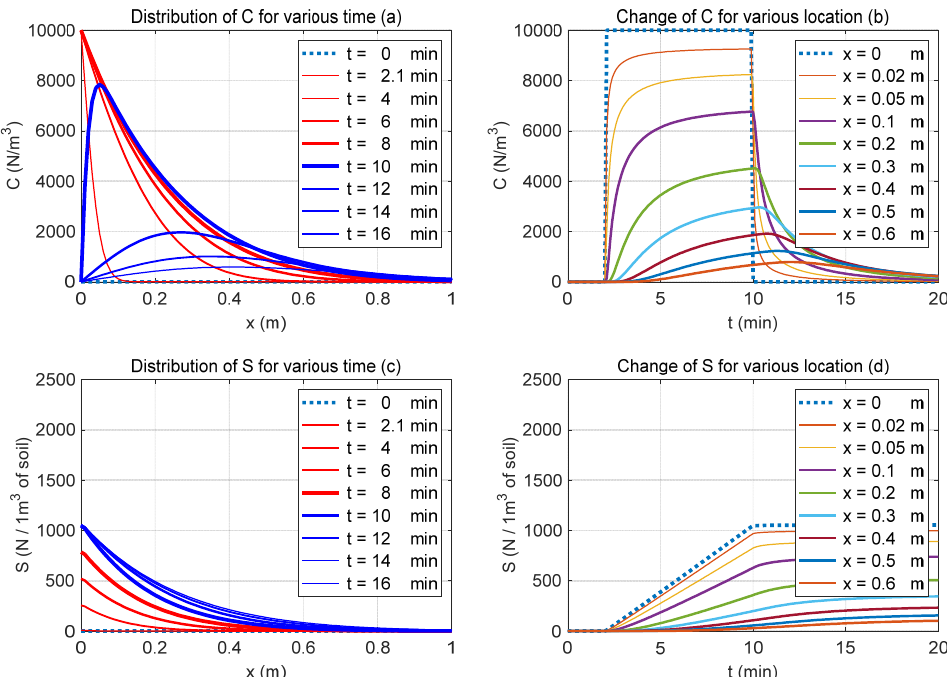
Figure 3. Simulation results for reference case S0: ( a ) distribution of C at various times, ( b ) variation in C at various locations, ( c ) distribution of S at various times, and ( d ) variation in S at various locations.